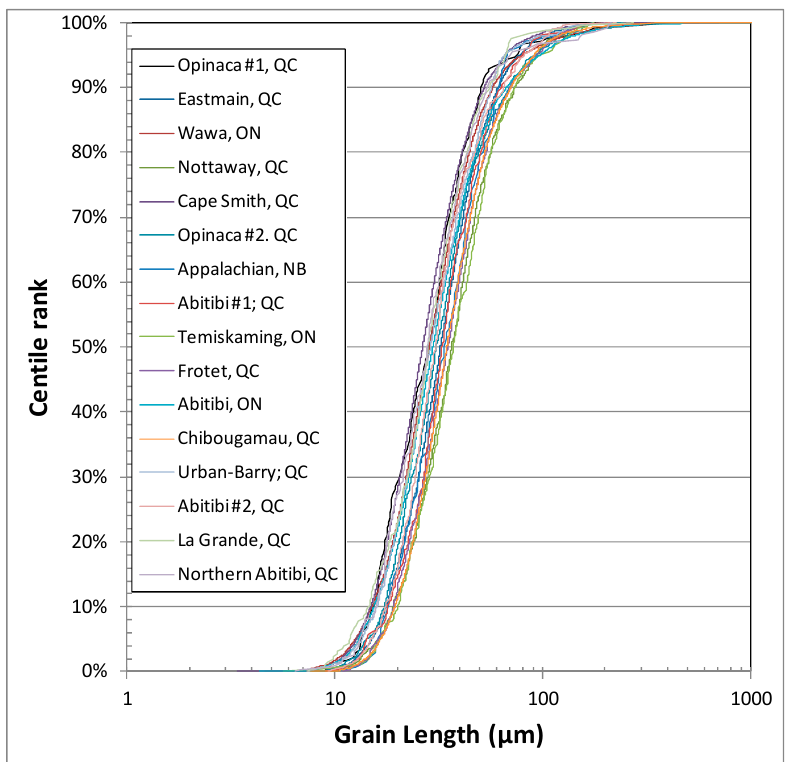
Figure 3. Gold grain size cumulative distribution plot for 16 recent sampling programs (Figure 1) where samples were collected with hand shovel by the same crews. Only genuine lodgment tills were included to ensure homogeneity. The surveys are dominantly located within the Superior Archean craton, testing for orogenic gold deposit in northwestern Québec and northeastern Ontario. One survey (Cape Smith) is located in the early Proterozoic mobile belt, while another (Appalachian) is located in Paleozoic terrain. All curves are very similar, parallels, with less than 10% variation of their mean, or 3% of the mean of the logarithm of the grain sizes. This is suggestive that gold grain size distribution is not significantly influenced by their source or metallogenic context. Severe divergence of such curves would be indicative of laboratory recovery issue or sorting in the